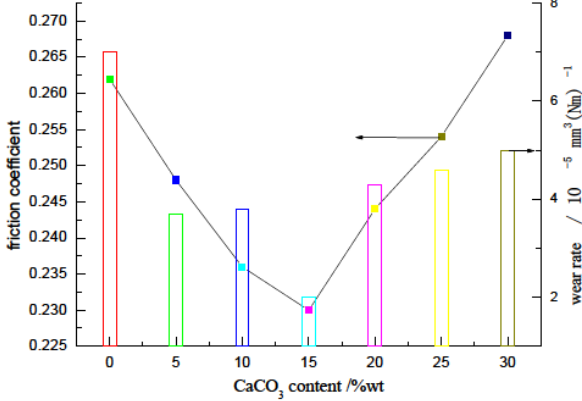
Figure 3: Effects of whisker content on tribological properties of